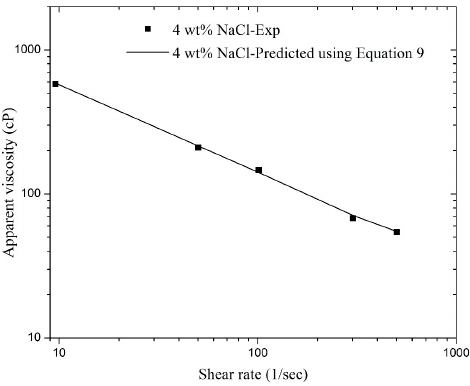
Figure 10. Validation of Equation (9).